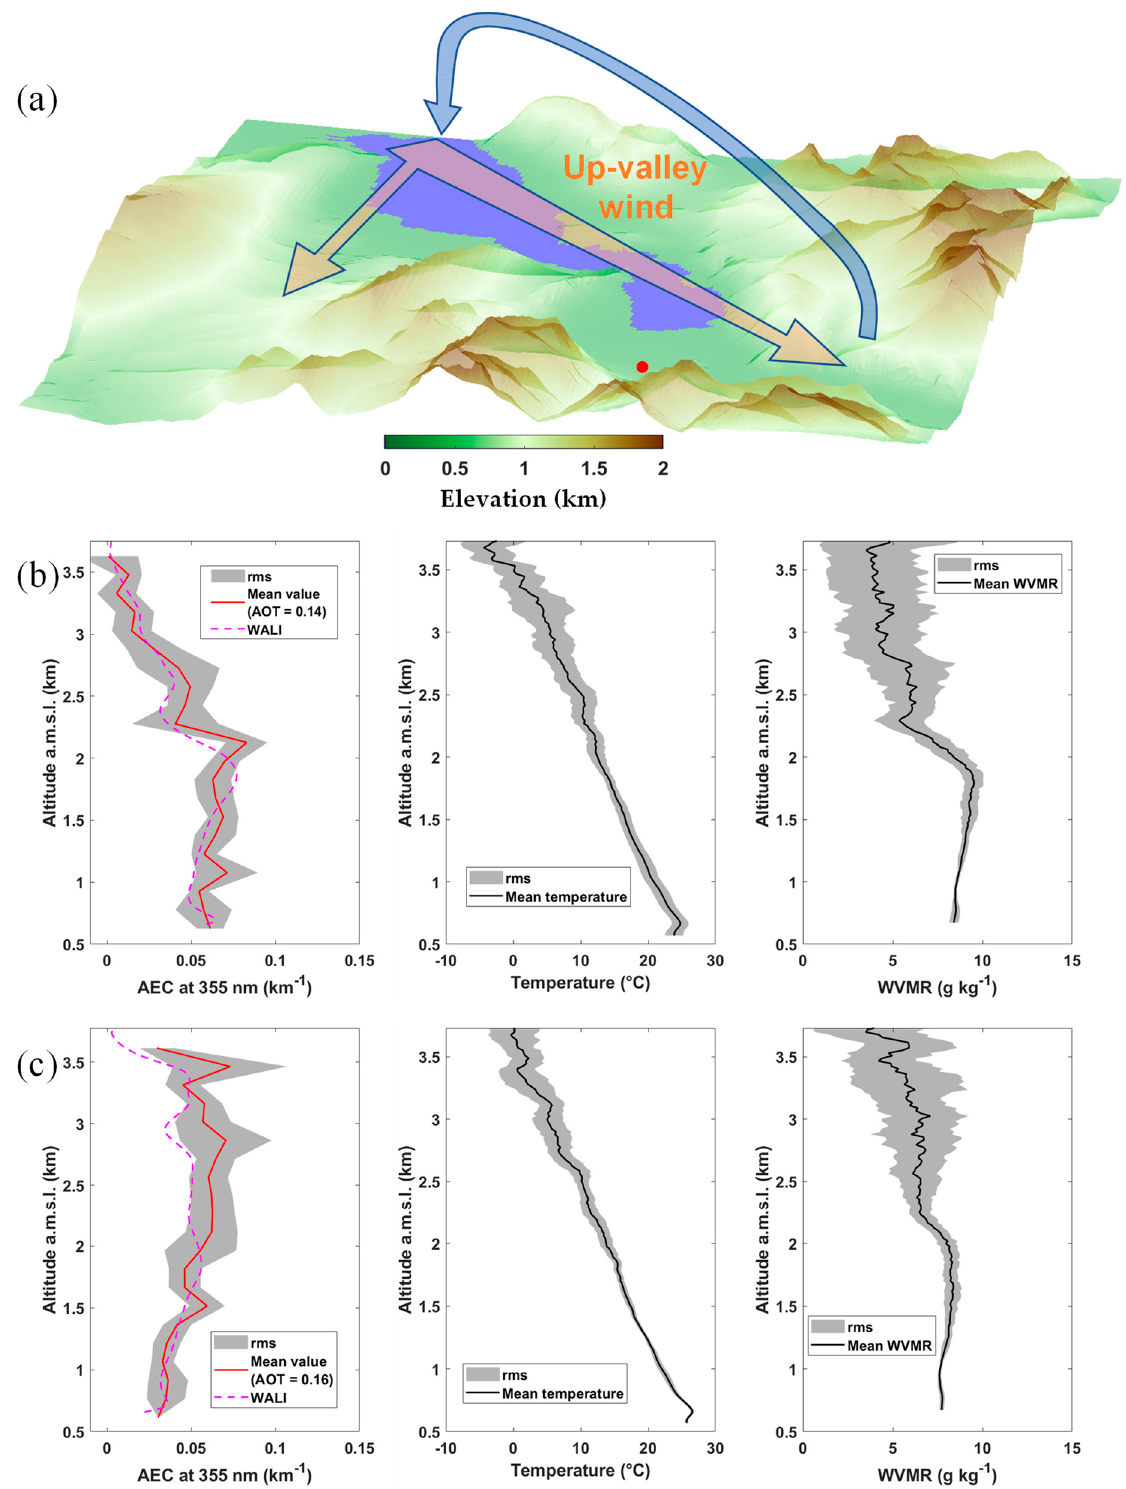
Figure 5. ( a ) Schematic representing the circulation patterns in the Annecy valley associated with the vertical lidar profiles shown below, in ( b , c ). Vertical profiles of the aerosol extinction coefficient (AEC), temperature, and water vapor mixing ratio (WVMR) during ultralight flights on ( b ) 17 June 2019, 15:45–17:00 LT, as well as ( c ) 17 June 2019, 17:45–19:00 LT. The ground-based lidar location is indicated by a red dot.